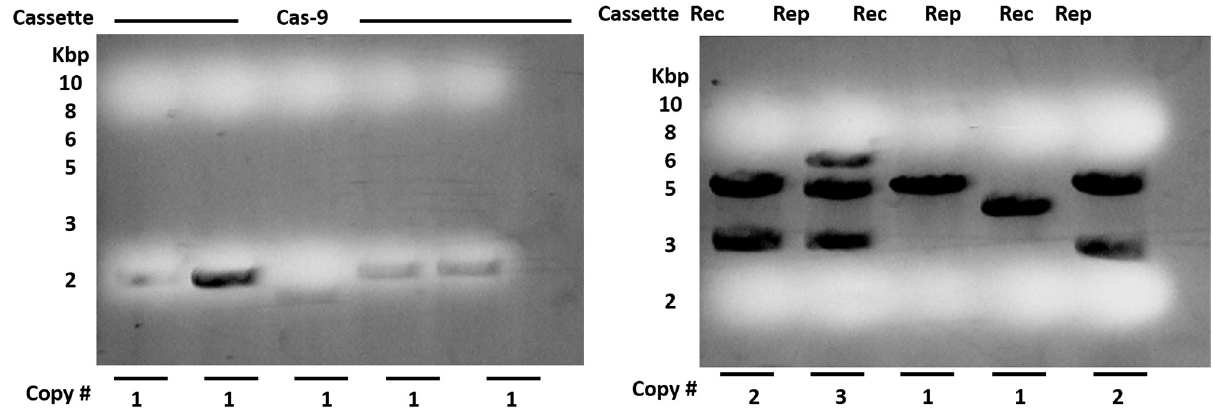
Fig 6. Copy number measurement in cotton transgenics. (Blot hybridization analysis in transgenic cotton genomic DNA hybridized with labeled probe (nptII, hptII and Cas9 genes). The approximate DNA length is shown to the right and cassettes integrated in particular transgenic are shown above the